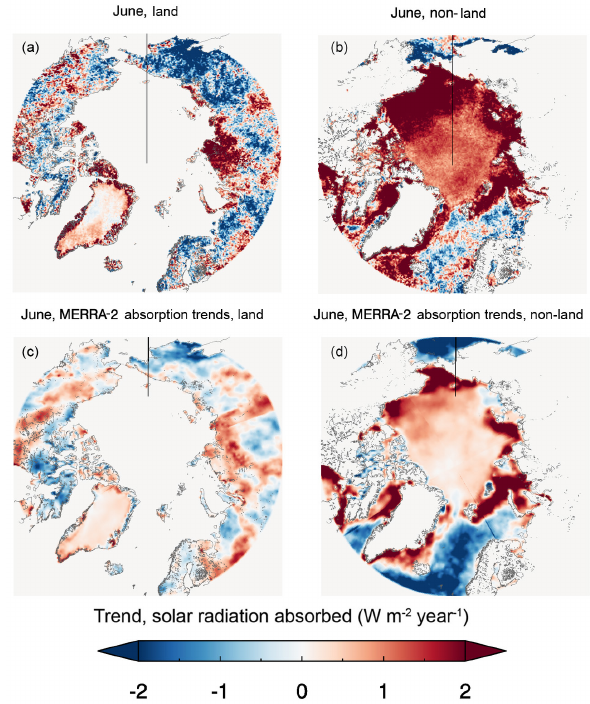
Figure 4. Trends in absorbed radiation from APP-x over land (a) and ocean (b) compared to trends from MERRA-2 over land (c) and ocean (d) during